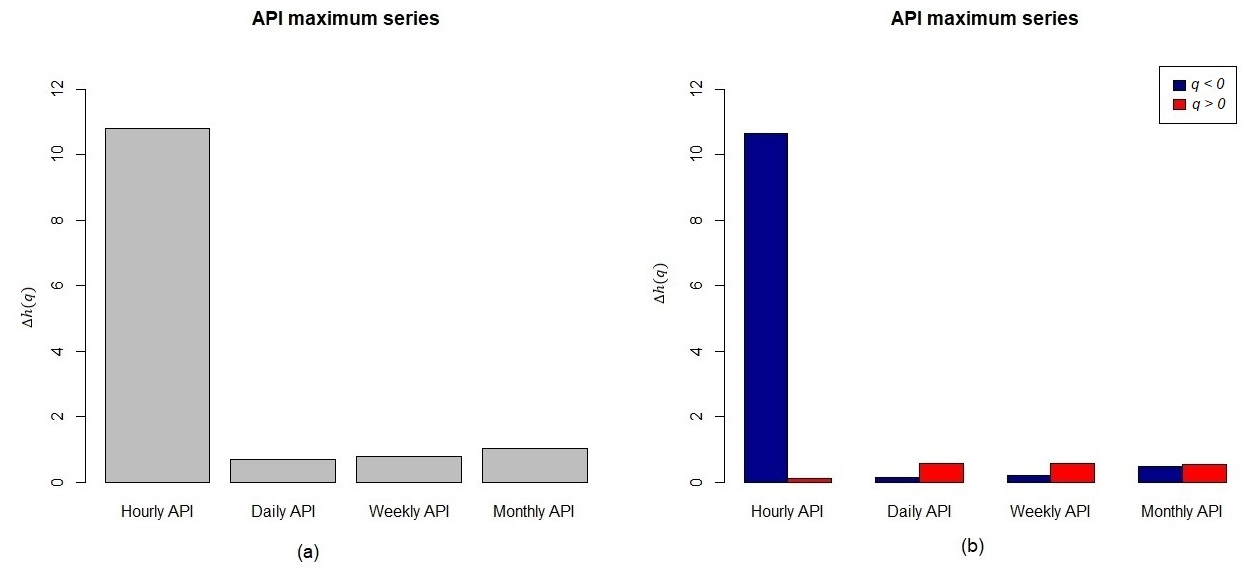
( ) Δ h q values for API series with different durations in Klang, ( b ) sectional Figure 7. ( a ) ∆ h ( q ) values for API series with different durations in Klang, ( b ) sectional ∆ h ( q ) Figure 7. ( a )